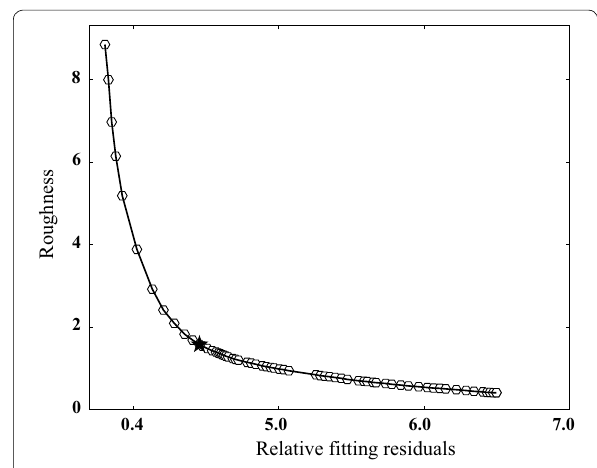
Fig. 3 Trade‑off curve of relative fitting residuals and roughness. The pentagram is the position of the smooth factor used